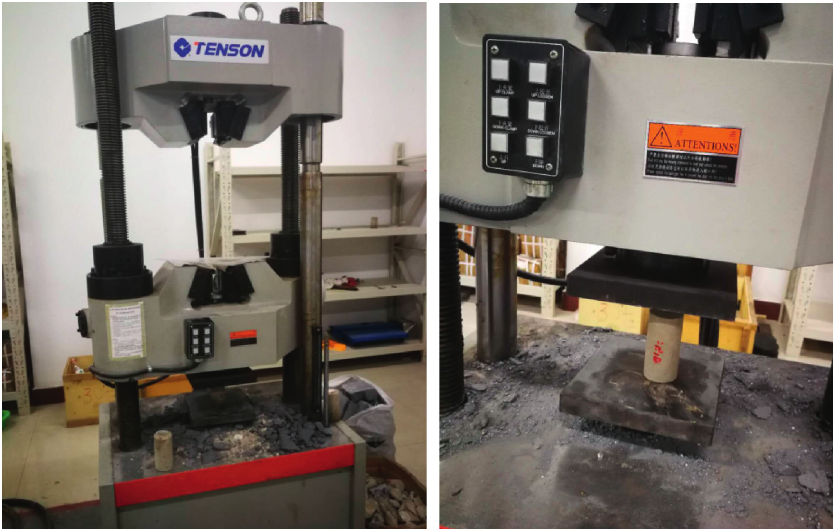
Figure 6: Microcomputer-controlled electro-hydraulic servo universal testing